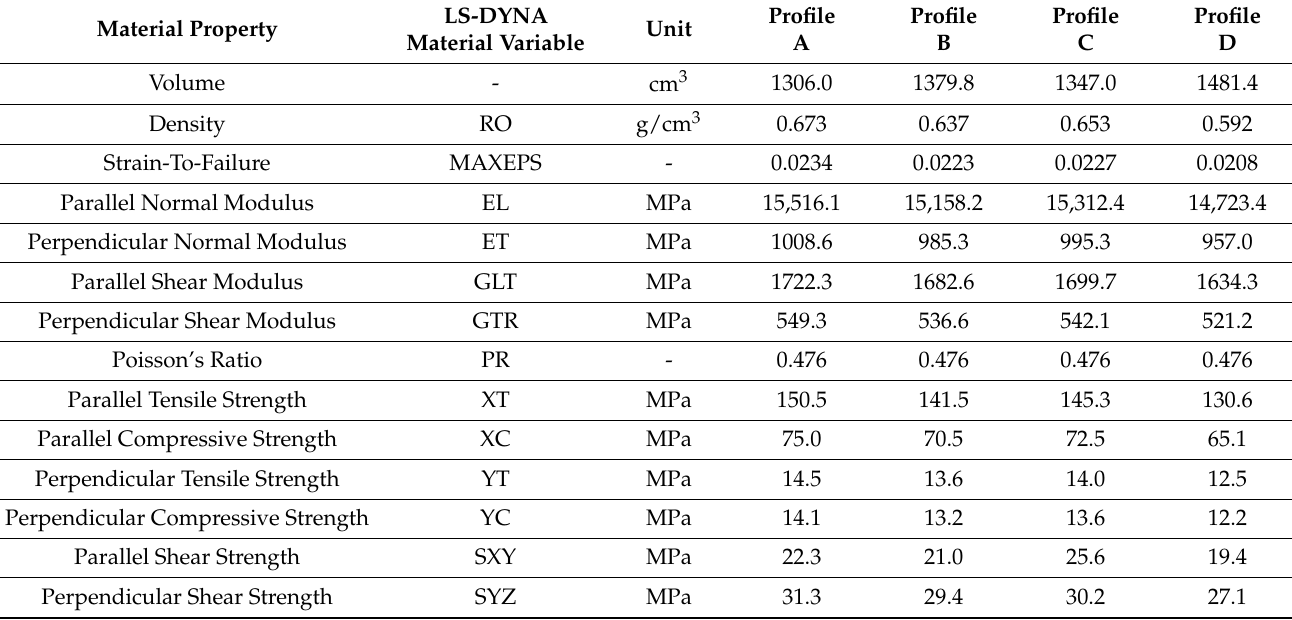
Table A2. Finite Element Model Material Properties in SI Customary